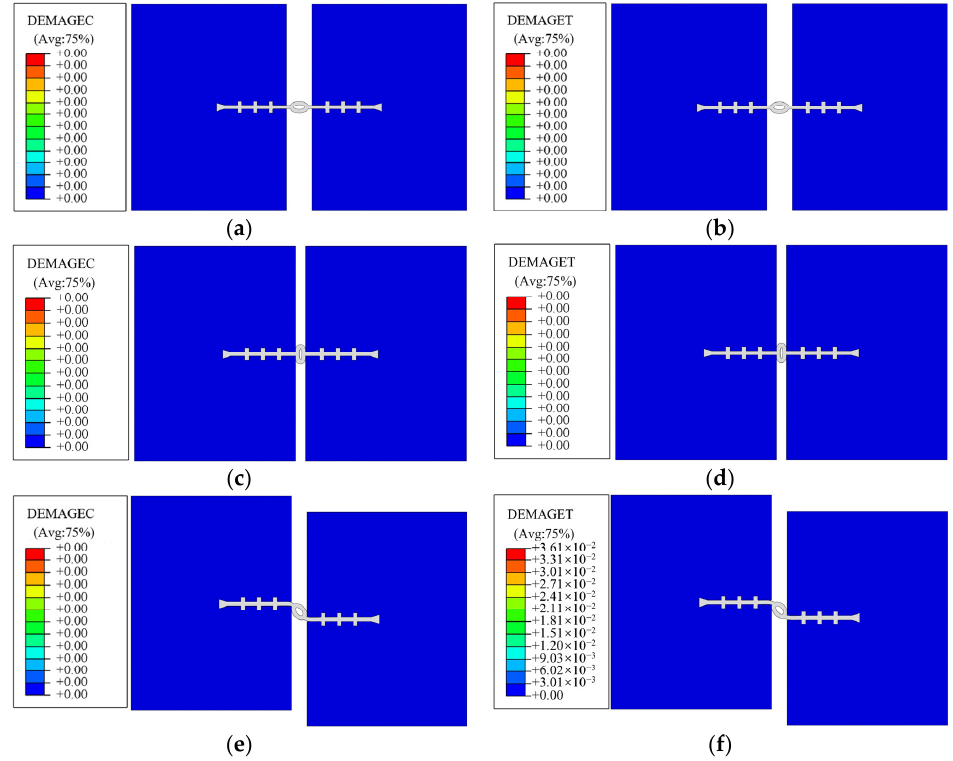
Figure 10. Damage cloud diagram of concrete stiffness in working condition 1. ( a ) 1-1 concrete compression damage. ( b ) 1-1 concrete tensile damage. ( c ) 1-2 concrete compression damage. ( d ) 1-2 concrete tensile damage. ( e ) 1-3 concrete compression damage. ( f ) 1-3 concrete tensile damage.